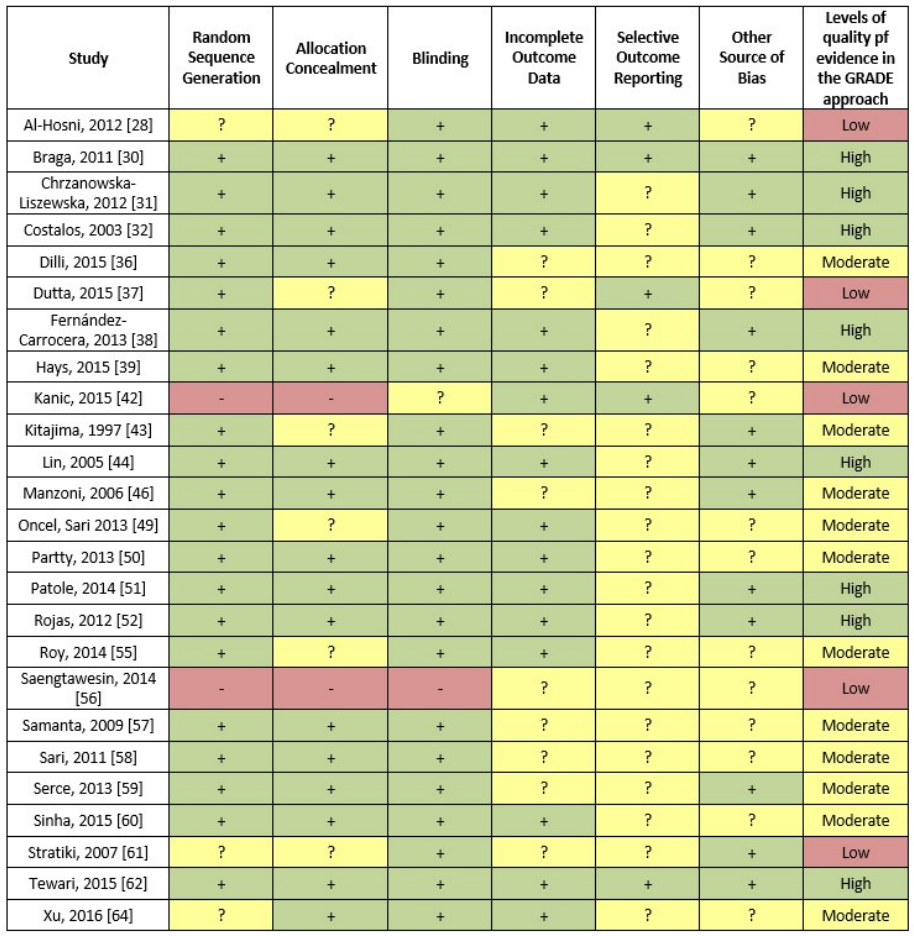
Figure 6. Evaluation of the quality of the studies included in the meta-analysis according to the risk of bias tool as proposed by the Cochrane collaboration (red represents a high risk of bias, yellow an unclear risk of bias and green a low risk of bias). In addition, the last column shows an assessment of the body of evidence using the GRADE working group approach.